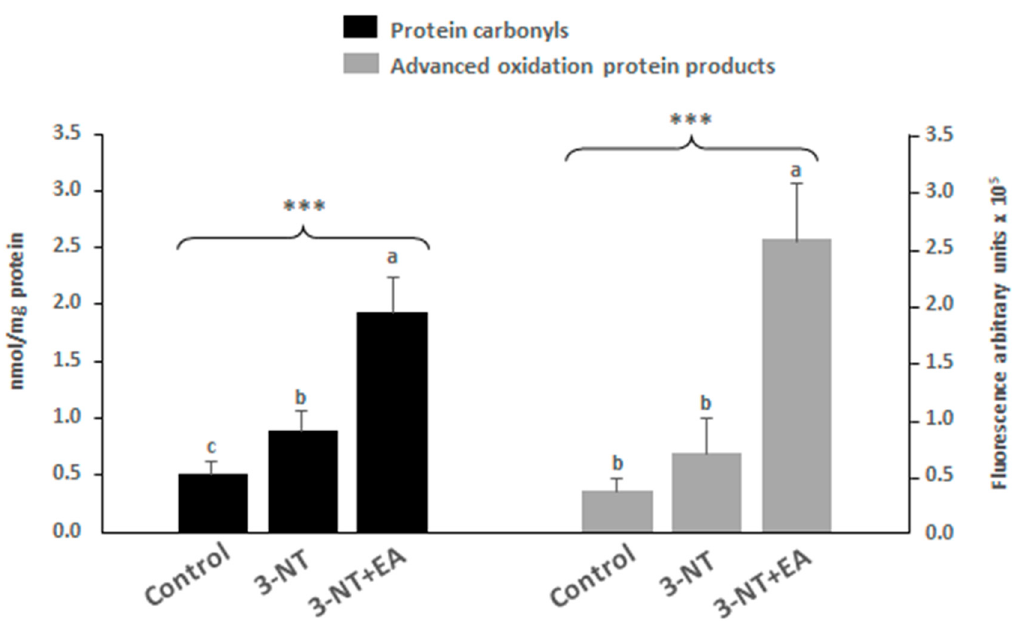
Figure 2. Protein carbonyls (nmol/mg protein of α -AS and γ -GS) (black bars) and advanced oxidation protein products (Pentosidine; fluorescence intensity) (grey bars) on differentiated human enterocytes upon exposure to 200 µ M 3-NT and 200 µ M 3-NT+200 µ M EA for 72 h. Asterisks on top of bars denote significant differences between group of samples in ANOVA (*** p < 0.001). (a–c) Different letters on top of bars denote significant differences between means in post-hoc Tukey tests ( p < 0.05).